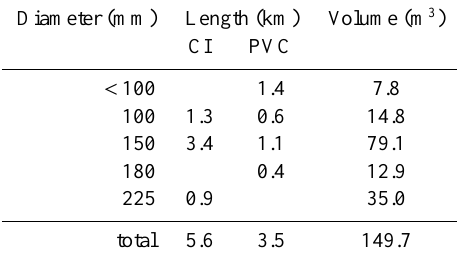
Table 1. Pipe diameters and materials in network.